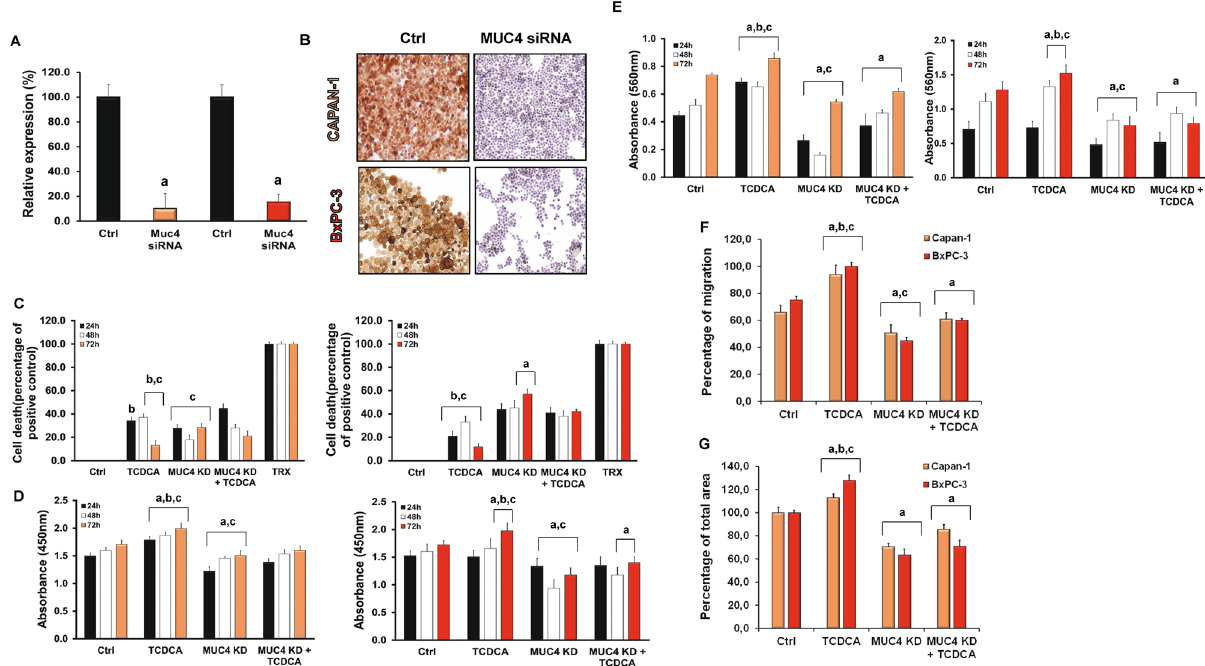
Figure 7. Knockdown of MUC4 in Capan-1 cells. The expression levels of MUC4 was investigated by RT-PCR ( A ) and immunohistochemistry ( B ) in control cells and in cells treated with specific siRNA for MUC4. Orange indicates Capan-1 whereas red BcPC-3 cells. The rate of viability ( C ), proliferation ( D ) and adhesion ( E ) was determined at 24, 48 and 72 h, whereas migration ( F ) and colony forming ( G ) at 72 h. Data represent mean ± SEM of three, independent experiments. a = p ≤ 0.05 vs. Control, b = p ≤ 0.05 vs. MUC4 KD, c = p ≤ 0.05 vs. MUC4 KD + TCDCA. TCDCA: taurochenodeoxycholic acid, KD: knock